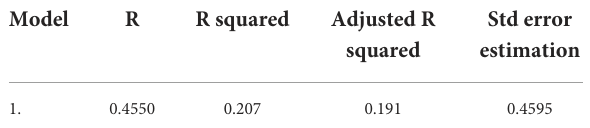
TABLE 1 Model summary. TABLE 2 List of selected